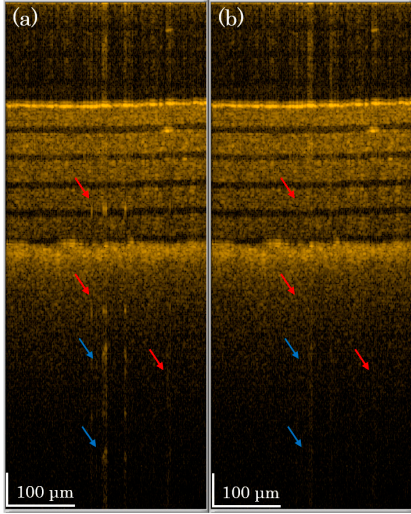
Figure 5. The B-mode scan image of 3 M Post-it Note paper with five layers of tape ( a ) without saturation artifact correction and ( b ) with the two-level compensation method.